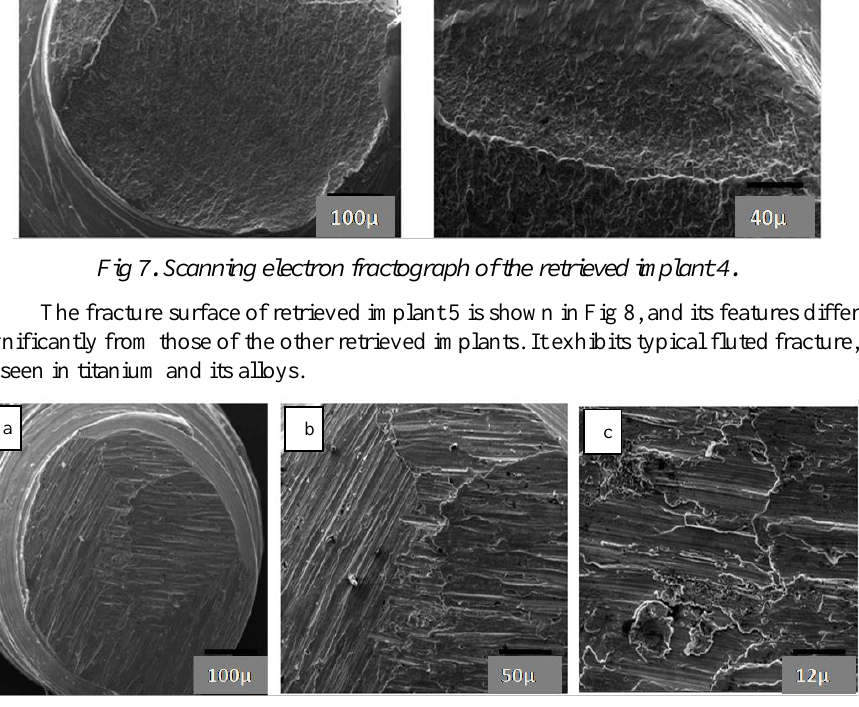
Fig 8. Scanning electron fractographs of the retrieved implant 5.